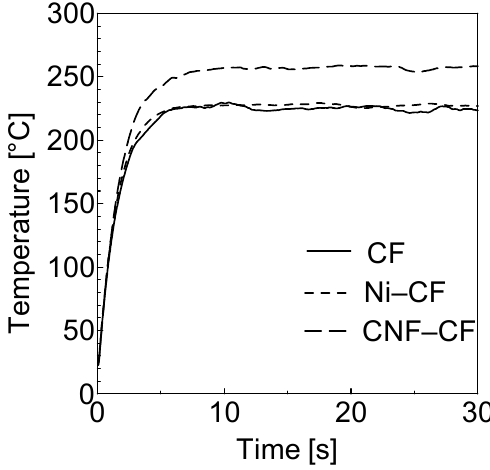
Figure 11. Temperature history of each carbon nanofilaments.